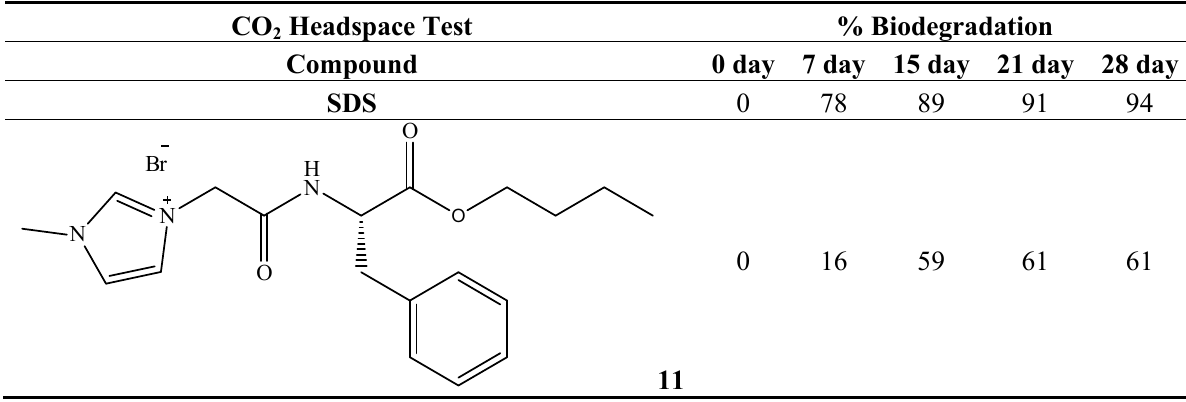
Table 5. Biodegradation data for amino acid derived ILs ( 11 ) and SDS internal standard. ( 11 ) is classed as readily biodegradable (ISO